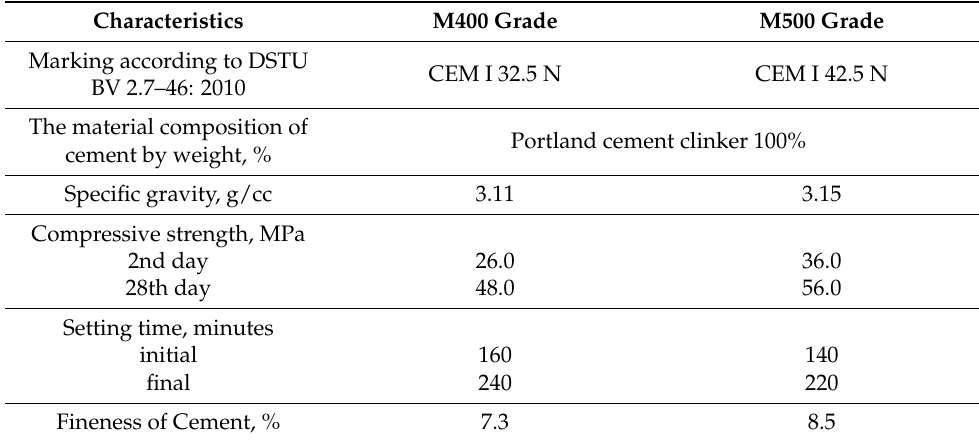
Table 2. Characteristics of the